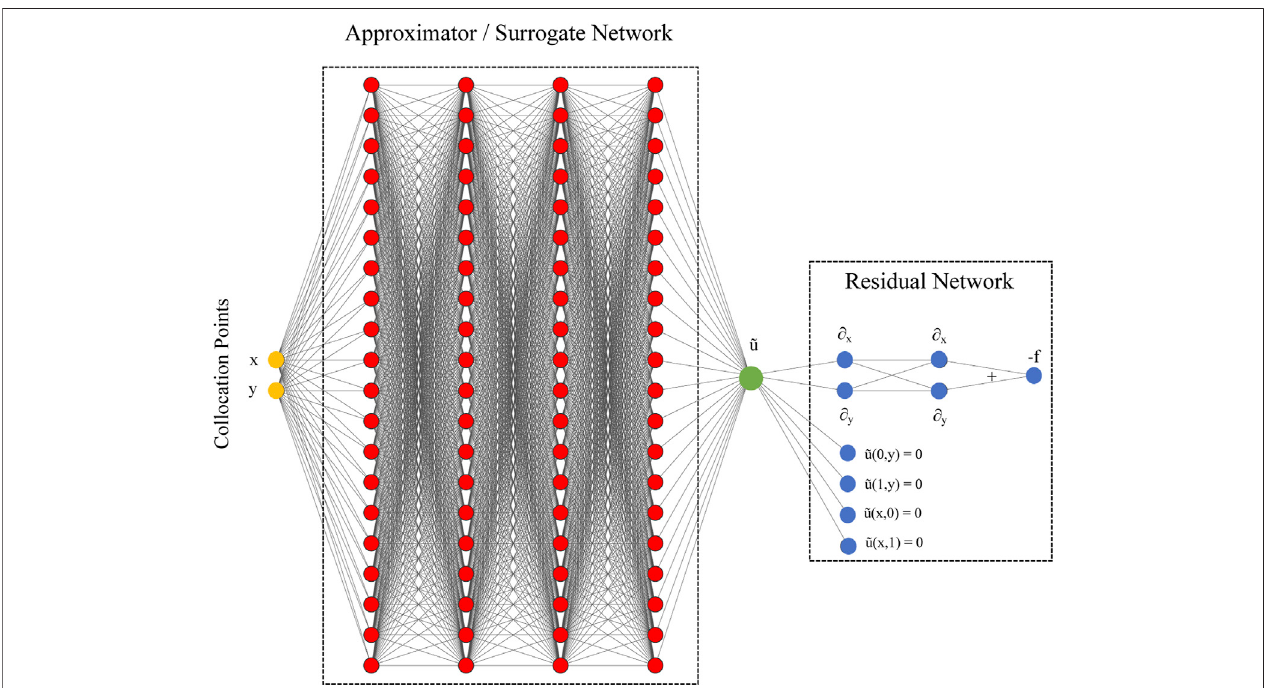
FIGURE 1 | A PINN to solve a Poisson problem z 2 x u ( x , y ) + z 2 y u ( x , y ) (cid:2) f ( x , y ) with associated Dirichlet boundary conditions. PINN consists of two basic interconnected networks. The fi rst network (red vertices) provides a surrogate or approximation of the problem solution u . The network takes as input a point in the problemdomain( x , y )andprovidesanapproximate solution ~ u .Thisnetworkweights andbiasesaretrainable.Thesecondnetwork(bluevertices)takestheapproximate solution from the fi rst network and calculates the residual that is used as loss function to train the fi rst network. The residual network includes the governing equations, boundary conditions and initial conditions (not included in the plot as the Poisson problem does not require initial conditions).